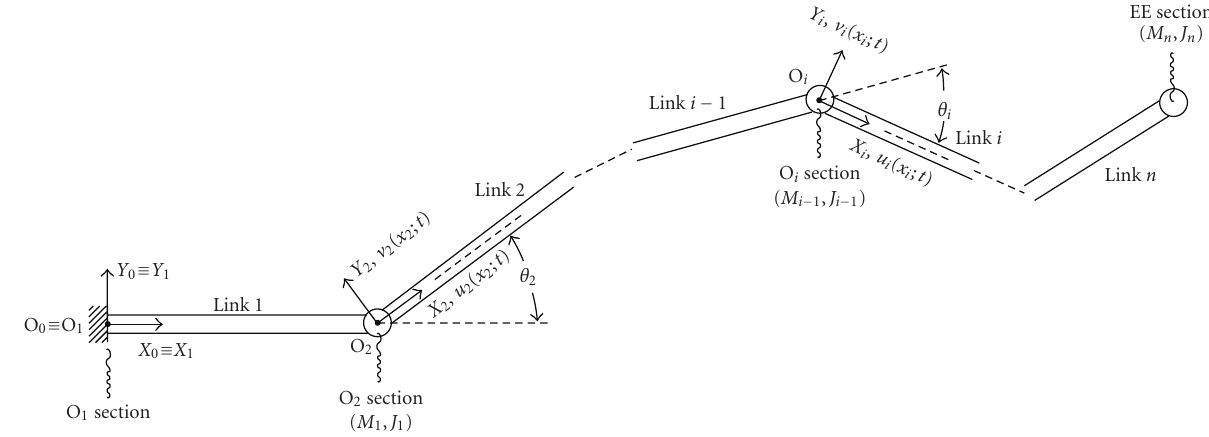
Figure 2: Notation describing of the multi-link flexible